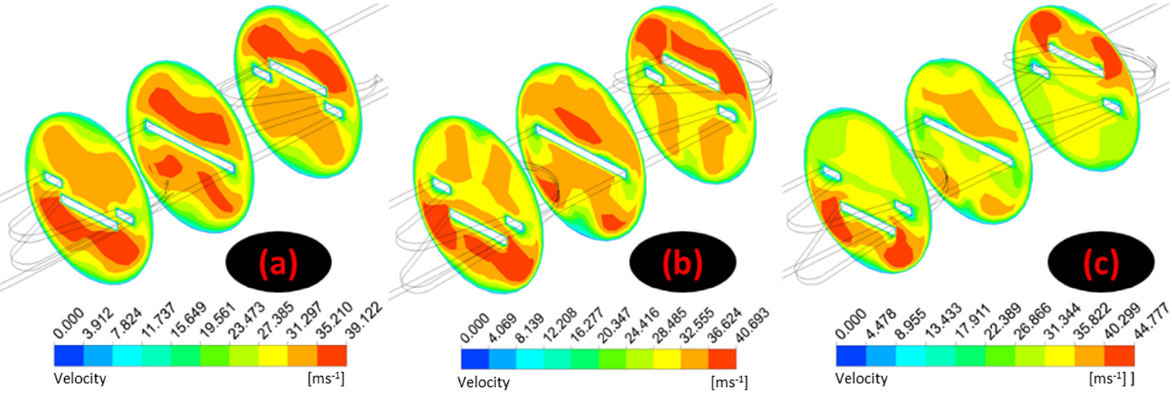
Figure 16. Velocity distribution along ( a ) 10°, ( b ) 15° and ( c ) 20° PWT inserts at section x 1 , x 2 and x 3 .